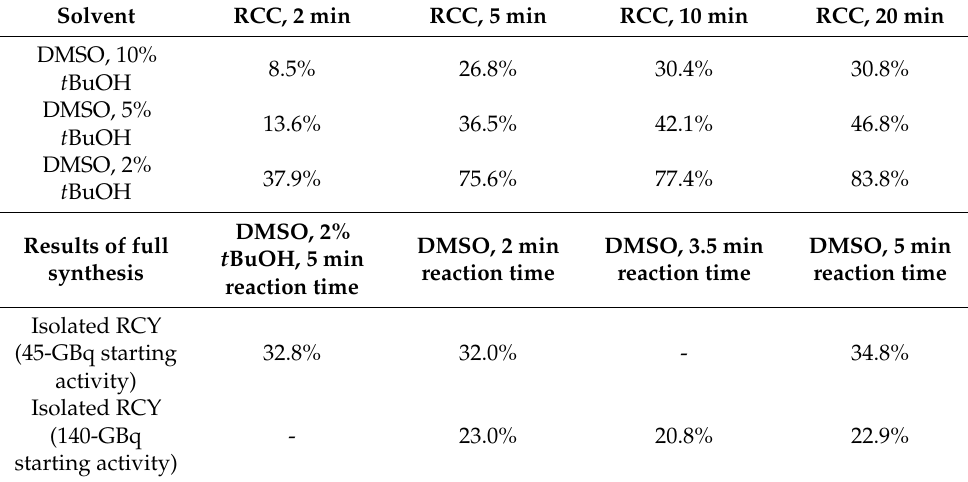
Table 3. Data from different efforts to try to overcome the problem of radiolysis with high-activity syntheses of [ 18 F]FE-PE2I. Top: manual experiments with low activity to see how much t BuOH is tolerated in the reaction solvent. Bottom: isolated RCY with either t BuOH added or the reaction time reduced (lines not